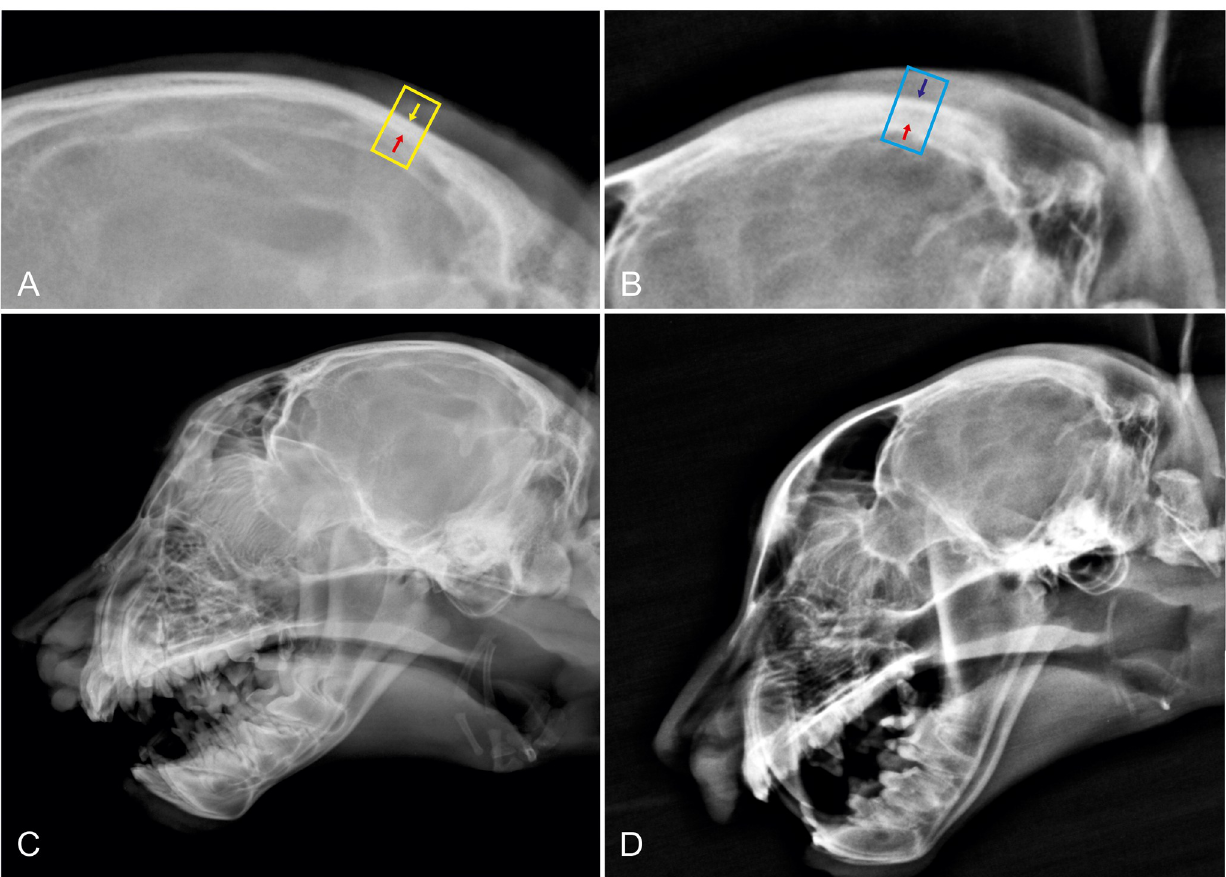
Fig 3. Parietal bone thickness in a healthy cheetah (A; C) compared to a cheetah with hypovitaminosis A (B, D). Red arrows mark the inner surface of the calvarial bones ( tabula interna ), the yellow and blue ones the outer surface ( tabula externa ) of the parietal bones in